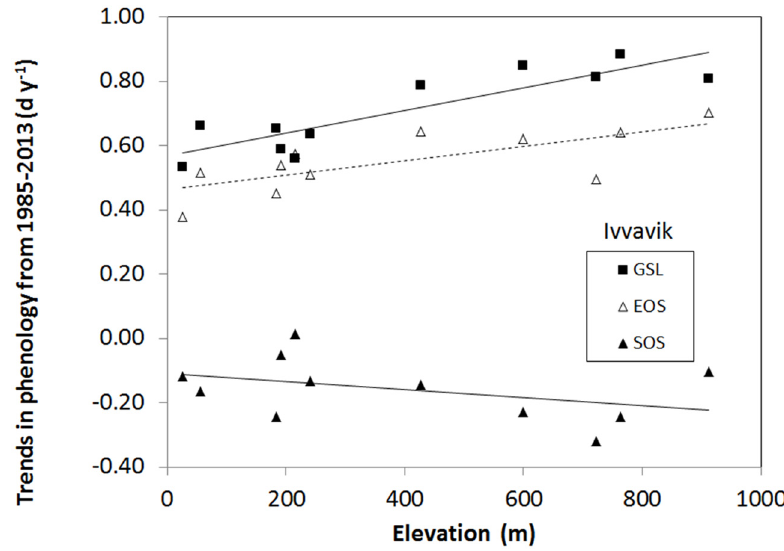
Figure 5. Relationships between SOS, EOS, or GSL trends (i.e., the slope of the trend line) during 1985–2013 and elevation for tundra classes in the Ivvavik National Park. Statistics for these relationships are listed in Table 4. Statistics for the relationships between phenology trend during 1985–2013 and elevation over the five study areas.